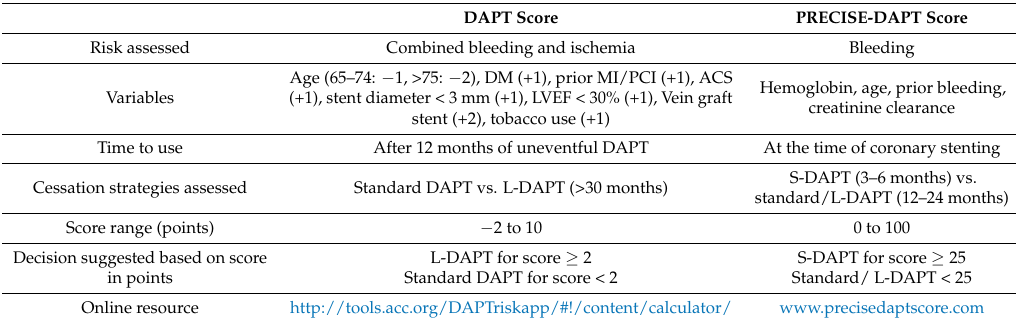
Table 7. Comparative features of tools for risk